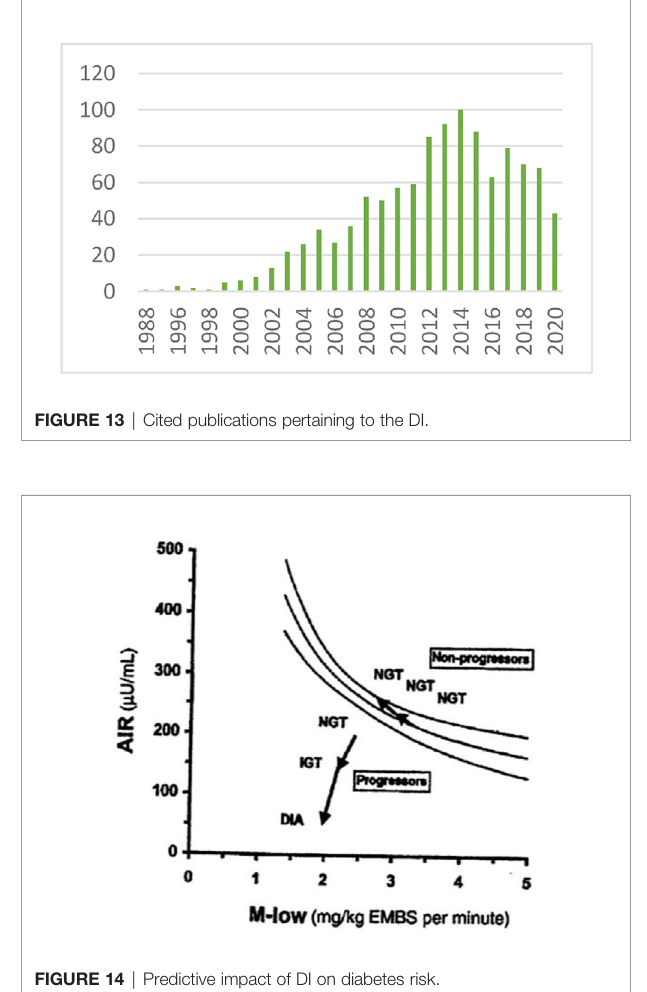
FIGURE 14 | Predictive impact of DI on diabetes risk.